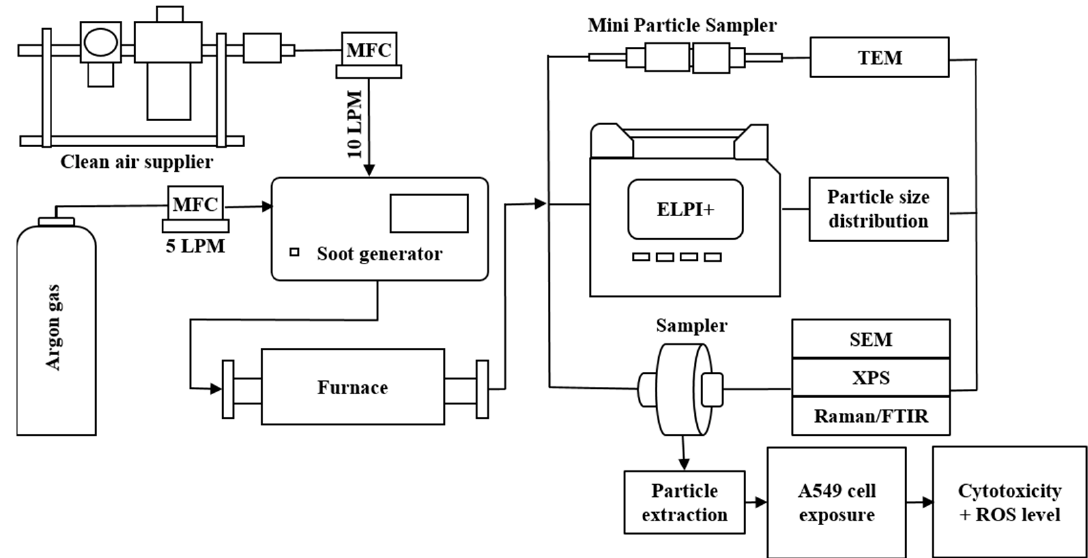
Figure 1. Schematic of the experimental setup.